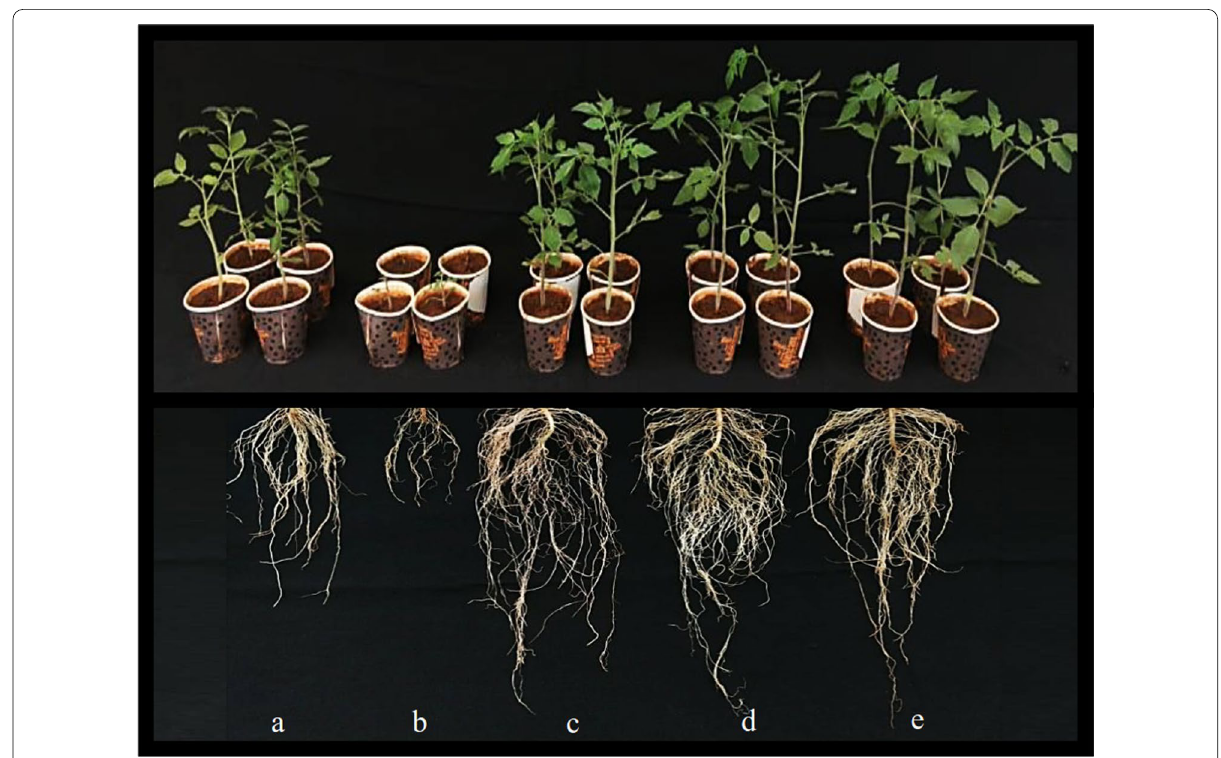
Fig. 4 Biological control of bacterial wilt and enhanced growth performance in tomato seedlings under greenhouse conditions using selected Bacillus antagonists. The parameters were determined until 30 dpi (day post-inoculation). a Uninoculated seedlings (control) neither by Bacillus spp nor Ralstonia solanacearum Rs5. b Ralstonia solanacearum Rs5-infected plants without an antagonist. c Ralstonia solanacearum Rs5-infected plants primed with Bacillusvelezensis CBv_BE1 alone. d Plantlets primed with Bacillus amyloliquefaciens CBa_BFL2 alone and grown on Rasltonia solanacearum Rs5-infected soil. e Plantlets primed with Bacillus amyloliquefaciens CBa_RA37 alone and grown on Ralstonia solanacearum Rs5-infected